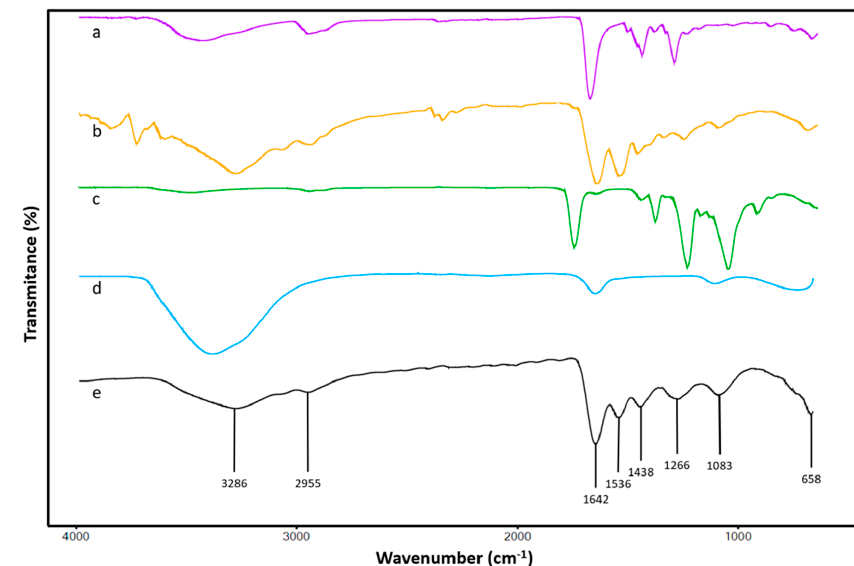
Figure 2. Attenuated total reflection Fourier transform infrared spectroscopy (ATR-FTIR) spectra from ( a ) PVP, ( b ) gelatin (GEL), ( c ) cellulose acetate (CA), ( d ) gentamicin and ( e ) scaffold. The latter shows